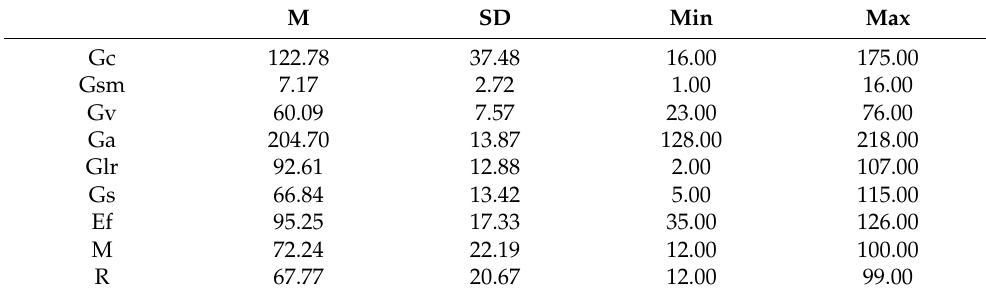
Table 1. Scores of Chinese students in grades 1 to 6 in Chinese, mathematics and cognitive abilities.